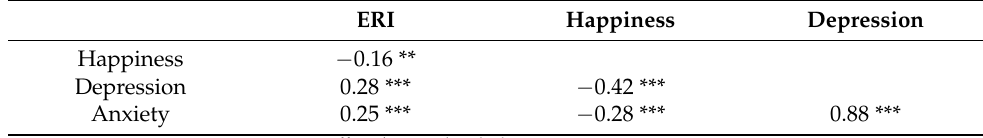
Table 3. Correlation matrix of the outcomes in the structural equation model in Figure 1. ERI Happiness Depression Happiness − 0.16 ** Depression 0.28 ***